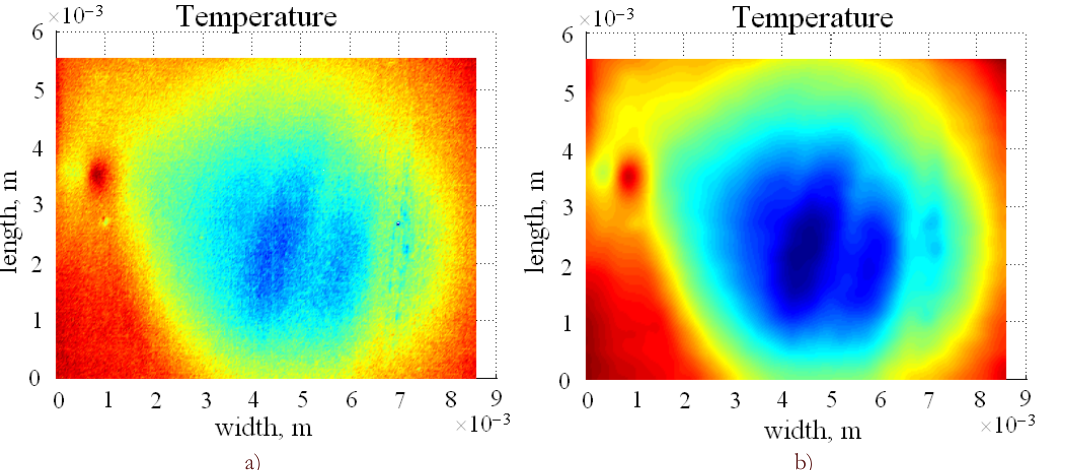
Figure 3: The temperature field before (a) and after (b) data processing.